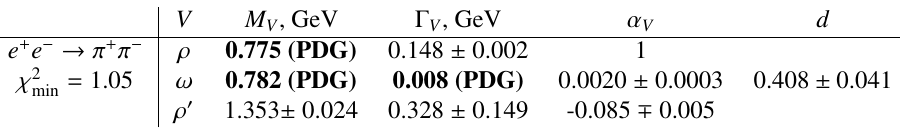
Table 1. The fitting results for the process e + e − → π + π −